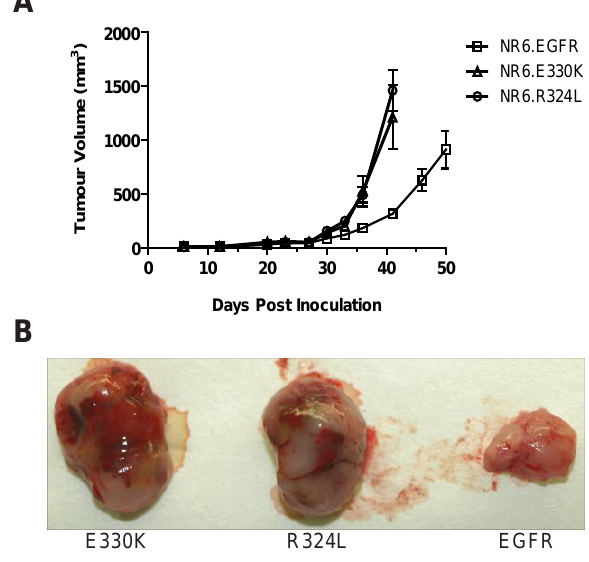
Figure 6. EGFR mutants promote in vivo tumor growth. Nude mice were injected subcutaneously into both flanks with transgenic NR6 cells containing wtEGFR, R324L or E330K. ( A ) Growth curves for NR6 cells expressing wtEGFR or R324L or E330K mutants. Data is presented as mean tumor volume ± S.E; ( B ) Gross tumors surgically resected for E330K, R324L and wtEGFR after 40